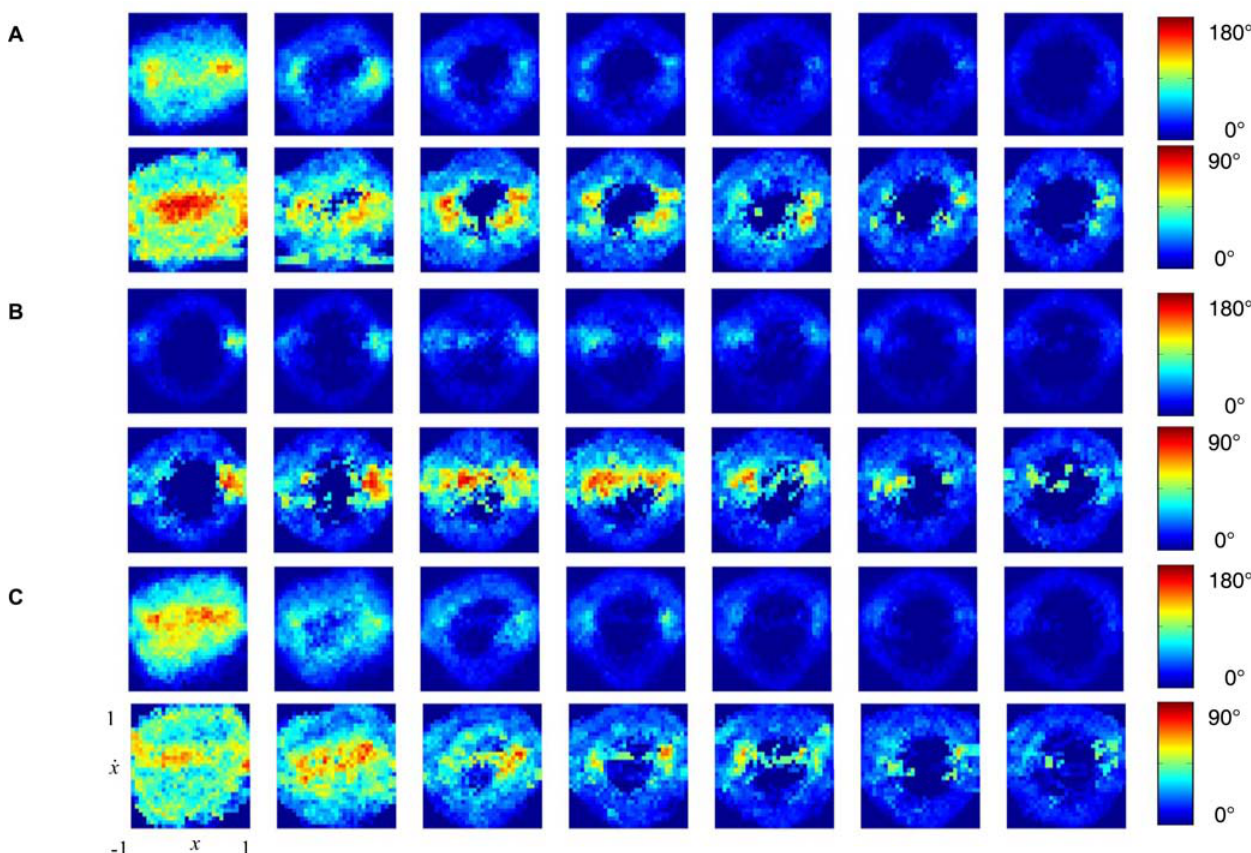
Figure 4. Reconstructed angle diagrams averaged across all participants as a function of movement pace and instruction condition. Horizontal axes represent normalized position ( x ); vertical axes represent normalized velocity ( _ xx ) (only indicated in lower left panel). (A) For the natural condition. (B) For the discrete condition. (C) For the smooth condition. For (A–C) the mean and standard deviation are depicted in the upper and lower row, respectively. The magnitude of the angles is represented through colour coding (right side of each